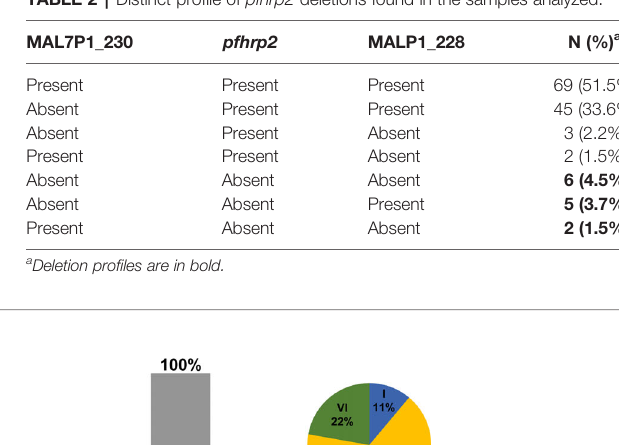
TABLE 2 | Distinct pro fi le of pfhrp2 deletions found in the samples